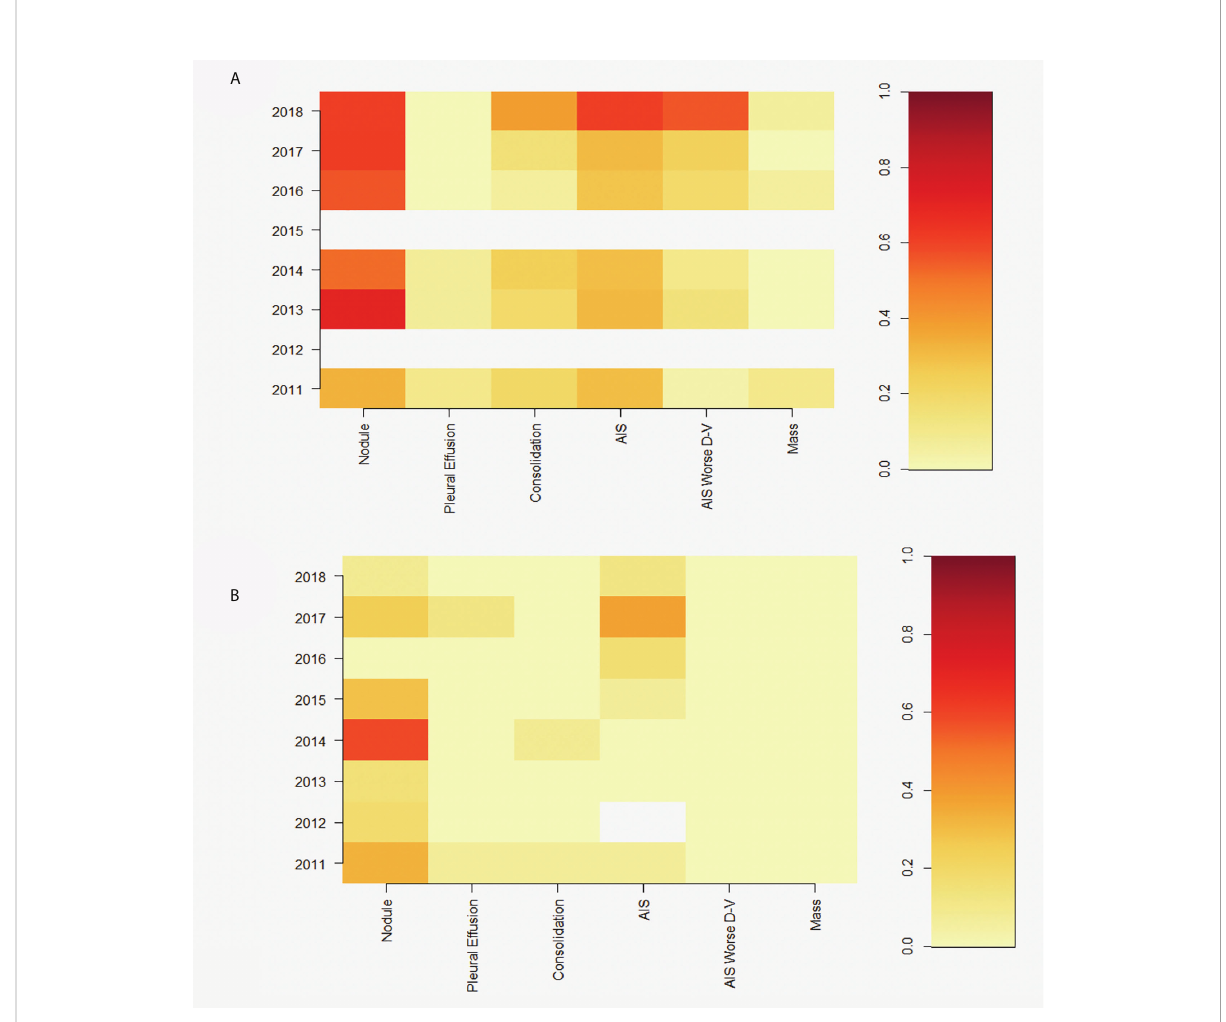
FIGURE 4 Heatmaps showing prevalence of pulmonary nodules ( ‘ nodule ’ ), pleural effusion, pulmonary consolidation ( ‘ consolidation ’ ), alveolar interstitial syndrome ( ‘ AIS ’ ), AIS with increased ventral severity ( ‘ AIS Worse D-V ’ ), and pulmonary masses ( ‘ mass ’ ) diagnosed between 2011-2018 in dolphins that were alive at the time of the DWH spill in (A) Barataria Bay (N=132 dolphins) and (B) Sarasota Bay comparison site (N=85 dolphins). White cells represent missing data. Colors represent prevalence of conditions, as represented in color key on the